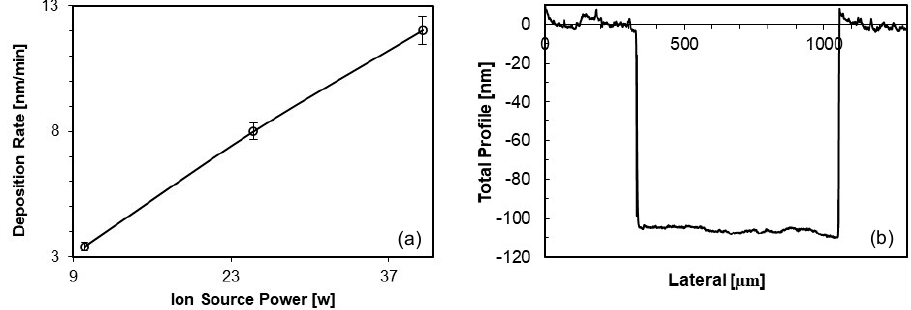
Figure 2. ( a ) Deposition rate dependence on the ion source RF power and ( b ) surface profile of the a-C:H coating on a glass substrate.